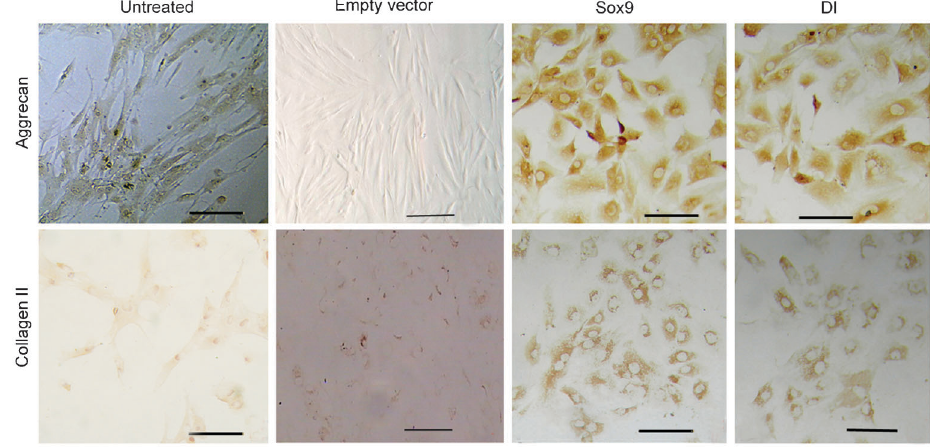
Figure 4. Sox9 overexpression induces chondrogenic differentiation in hUC-MSC cells. For induction of chondrogenic differentiation, cells were treated as described in Material and Methods. After the treatments, cells were subjected to immunocytochemistry for aggrecan and collagen II. Similar to the treatment with chondrogenic medium, genetic delivery of Sox9 markedly enhanced the expression of aggrecan and type II collagen in hUC-MSCs. DI: differentiation-induced group. Bar = 50 m